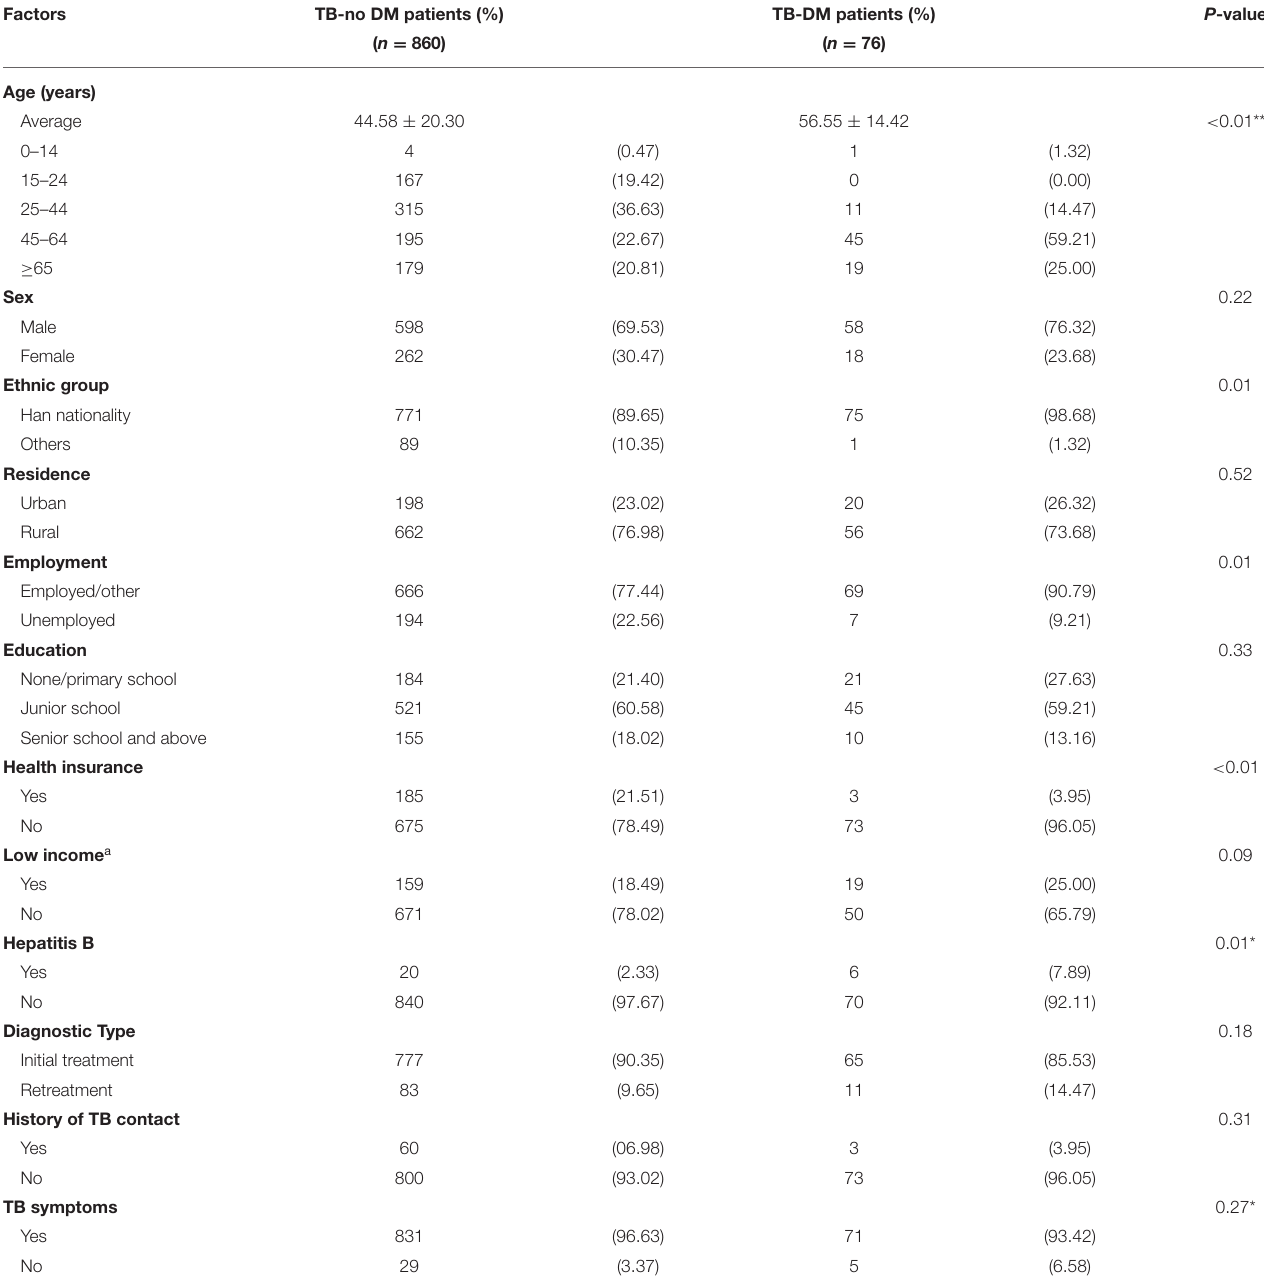
TABLE 1 | Baseline characteristics of tuberculosis (TB) cases with and without diabetes mellitus (DM).